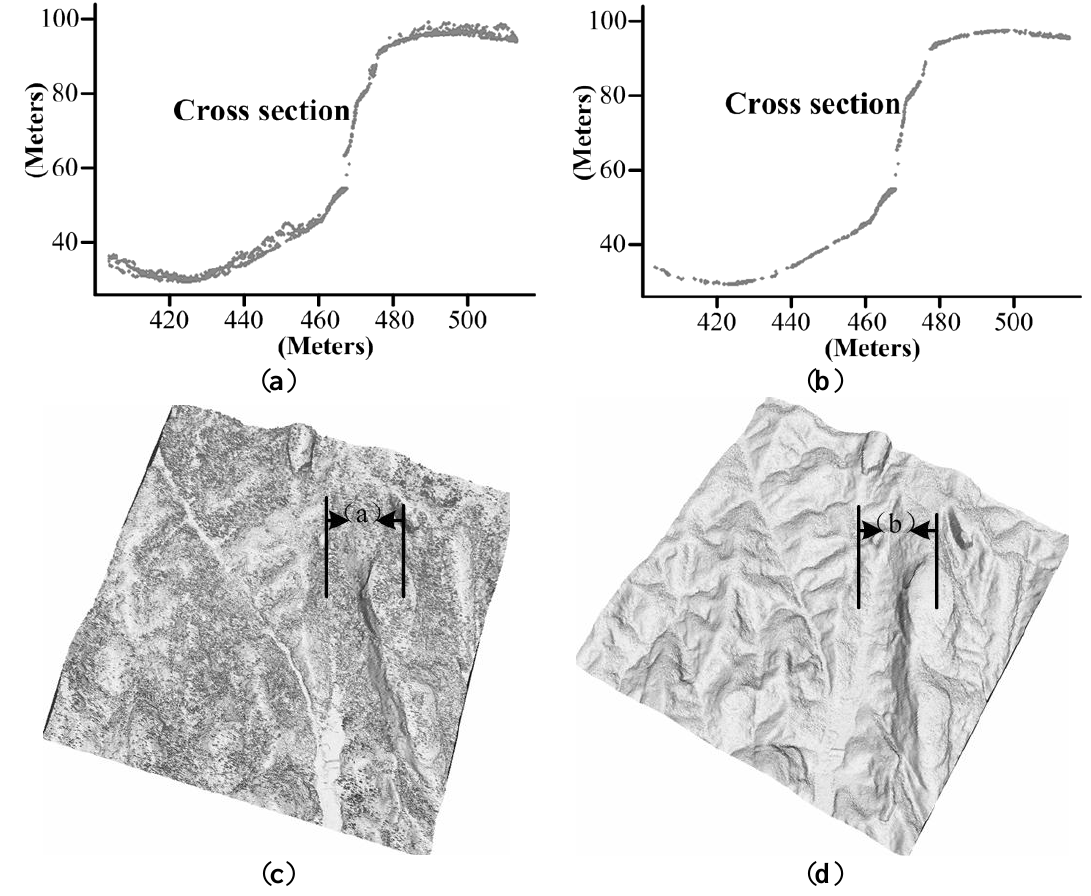
Figure 11. Preservation of steep slope: ( a ) and ( b ) are the cross sections; ( c ) is the raw point data; ( d ) is the DTM generated by